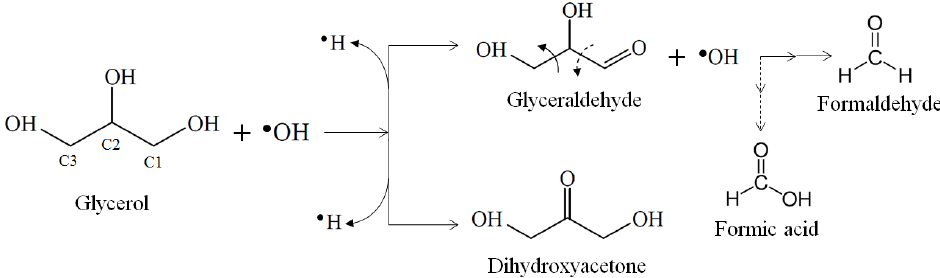
Figure 9. Proposed reaction scheme for the photo-oxidation of glycerol by Cu/TiO 2 .